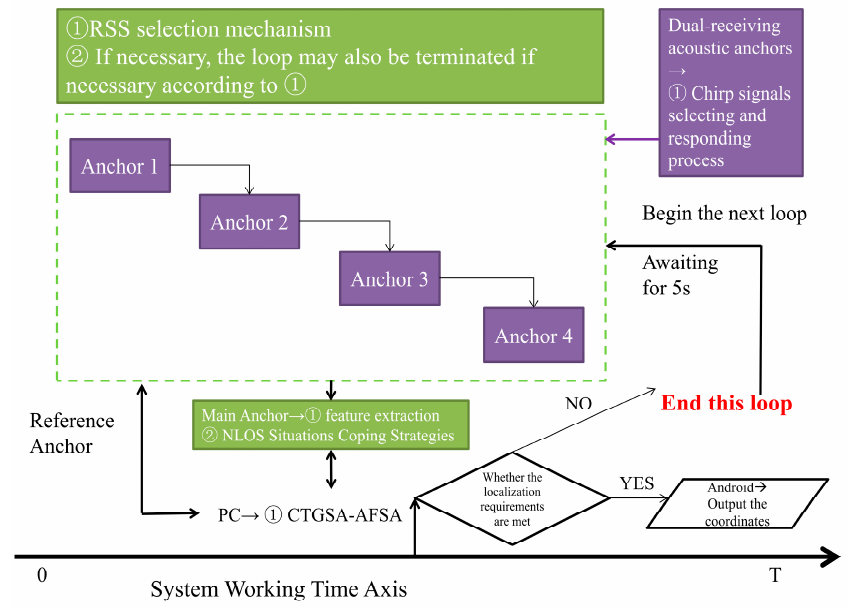
Figure 8. Indoor localization system working time axis in one localization loop.